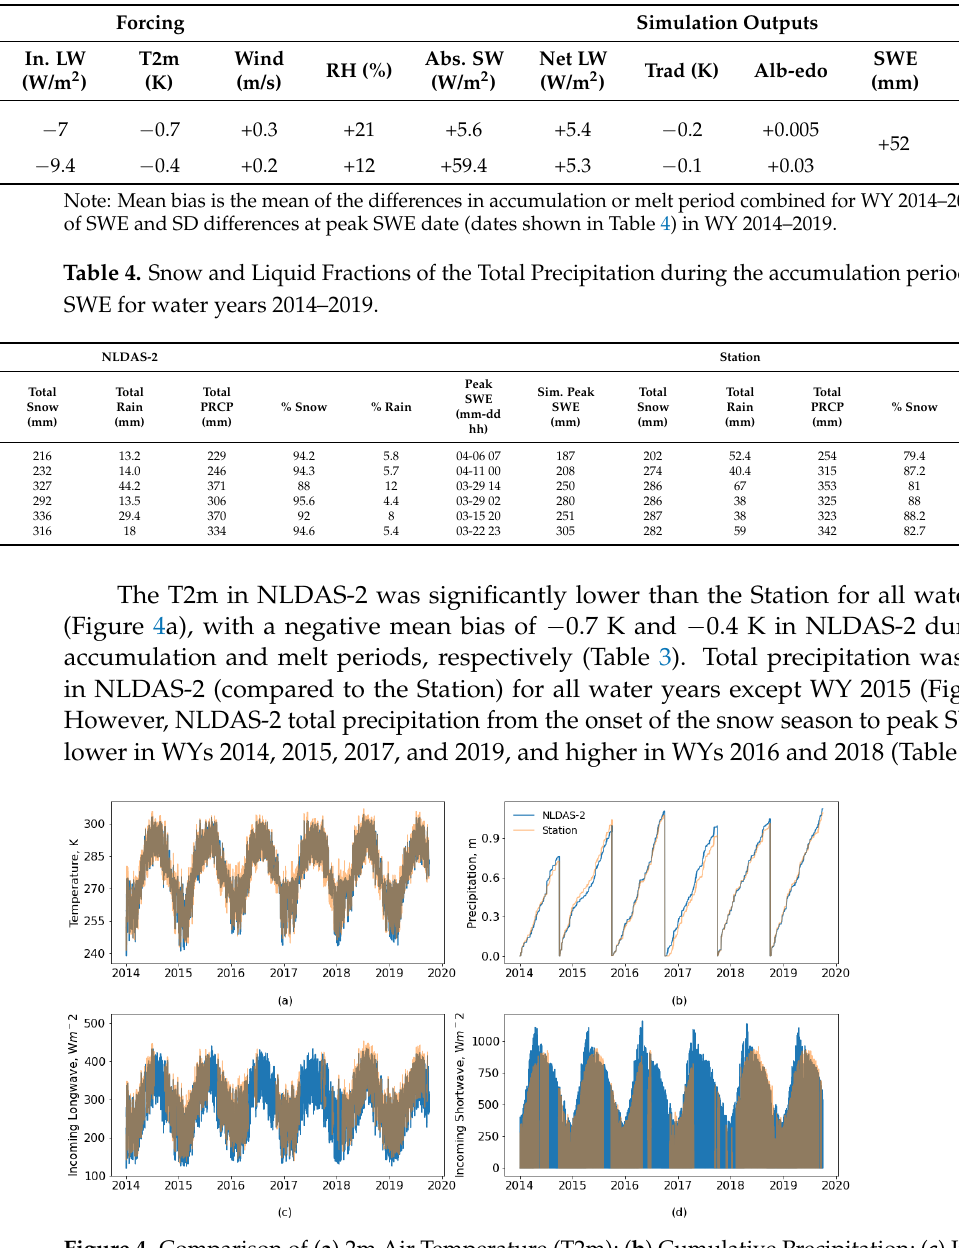
Table 3. Mean Bias in NLDAS-2 and NLDAS2-Noah-MP compared to the Station and Station-Noah- MP (WY 2014–2019).